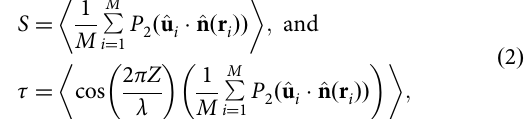
Fig. 2 Nematic director fi eld of a twist-splay-bend nematic phase. Precession cone (top panel) and orthogonal projection of the nematic director fi eld ^ n ð z j θ ; θ ; q Þ (bottom panel) of several limiting cases of the twist-splay-bend nematic (N TSB a b b the splay-bend nematic (N SB ) phase with θ b = 0, c the N TSB phase with θ a ≠ θ b , d the twist-bend (N TB ) phase with θ a = θ b , and ( e ) the cholesteric (N*) phase with θ a = θ b = π